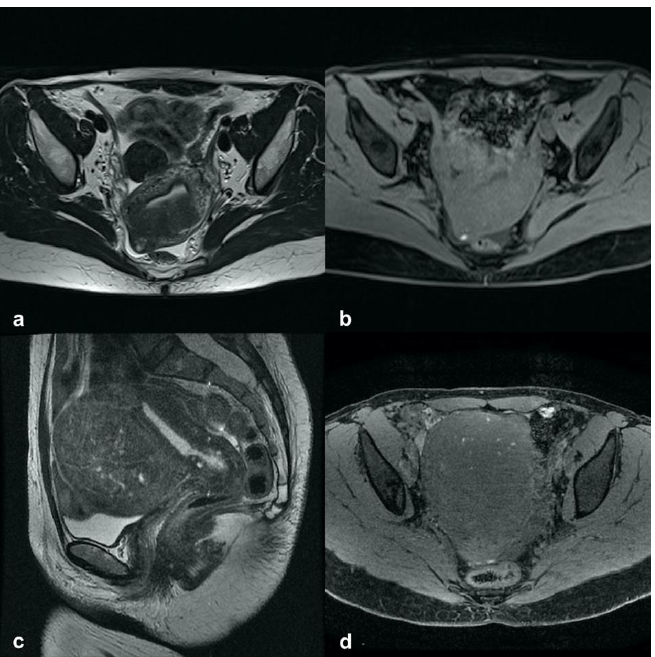
Figure 5. Adenomyoma: ( a , b ) subserosa adenomyoma with a small cystic component and hemorrhagic content. ( c , d ) Intramural solid adenomyoma: sagittal T2-weighted image showing an intramyometrial hypointense mass with ill-defined margins, minimal mass effect and tiny hyperintense cystic elements; axial T1-weighted image ( d ) showing high-signal cystic components within the adenomyoma, representing the ectopic glandular hemorrhagic content.